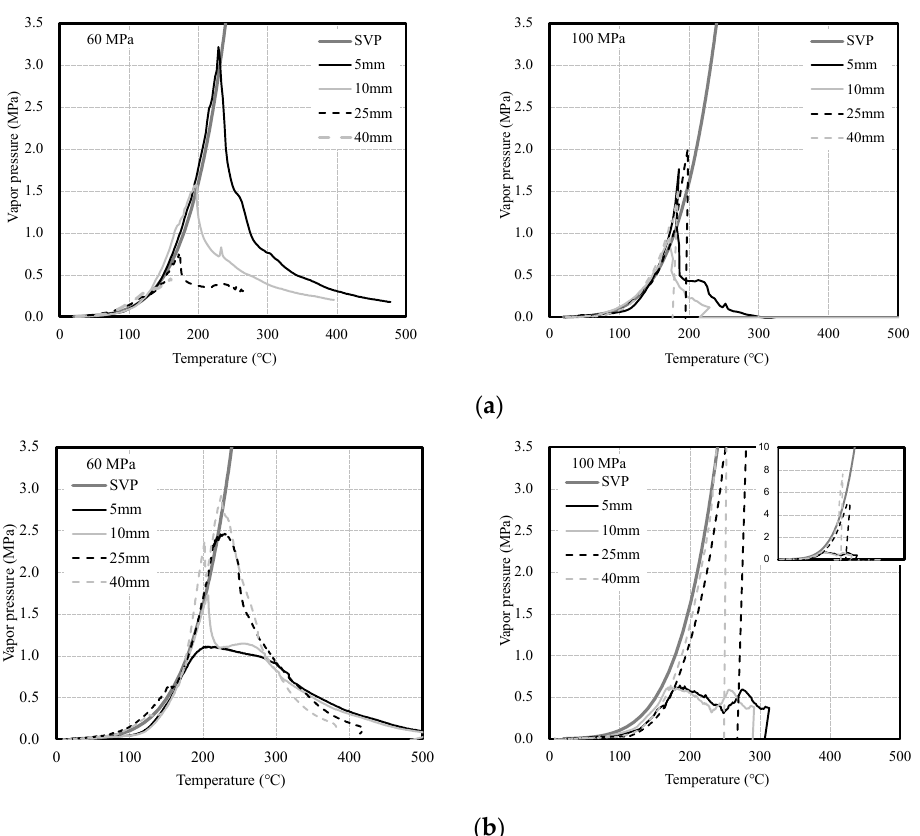
Figure 8. Comparison of the vapor pressure of concrete and the SVP curve according to heating rate. ( a ) Fast heating (ISO- 824). ( b ) Slow heating (1 °C/min).